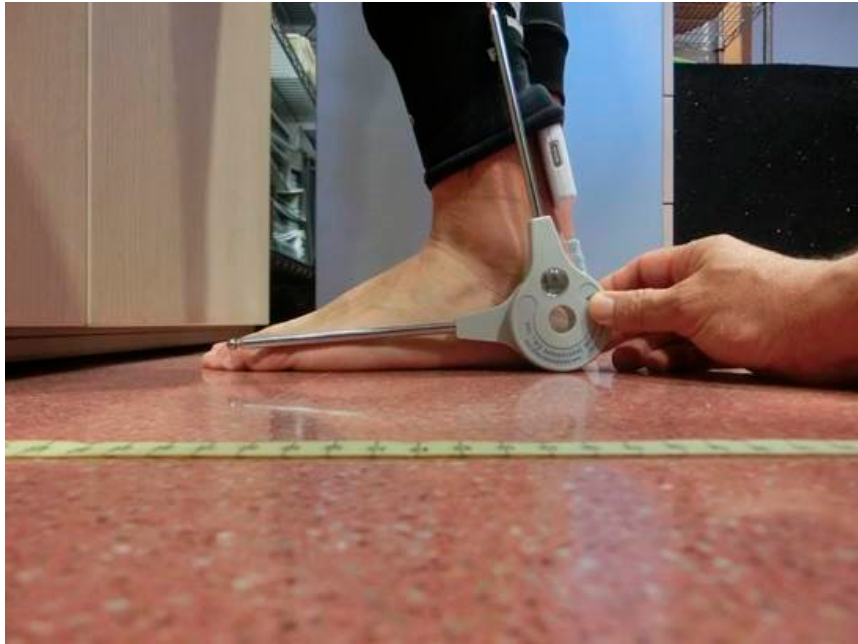
Figure 2. Measurement of ankle dorsiflexion with the knee in extension. WIMU TM is attached to the Achilles tendon.